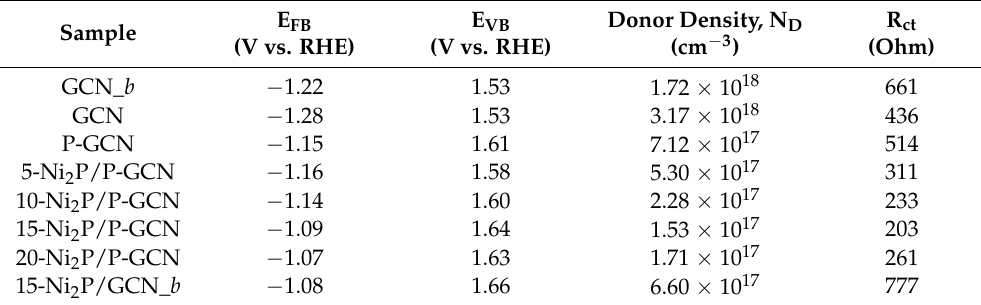
Table 1. Electrochemical results deduced from EIS analysis for various